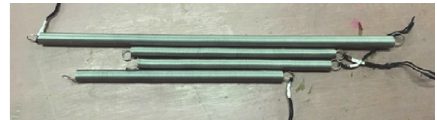
Figure 6: The different extension springs used in the experiments.